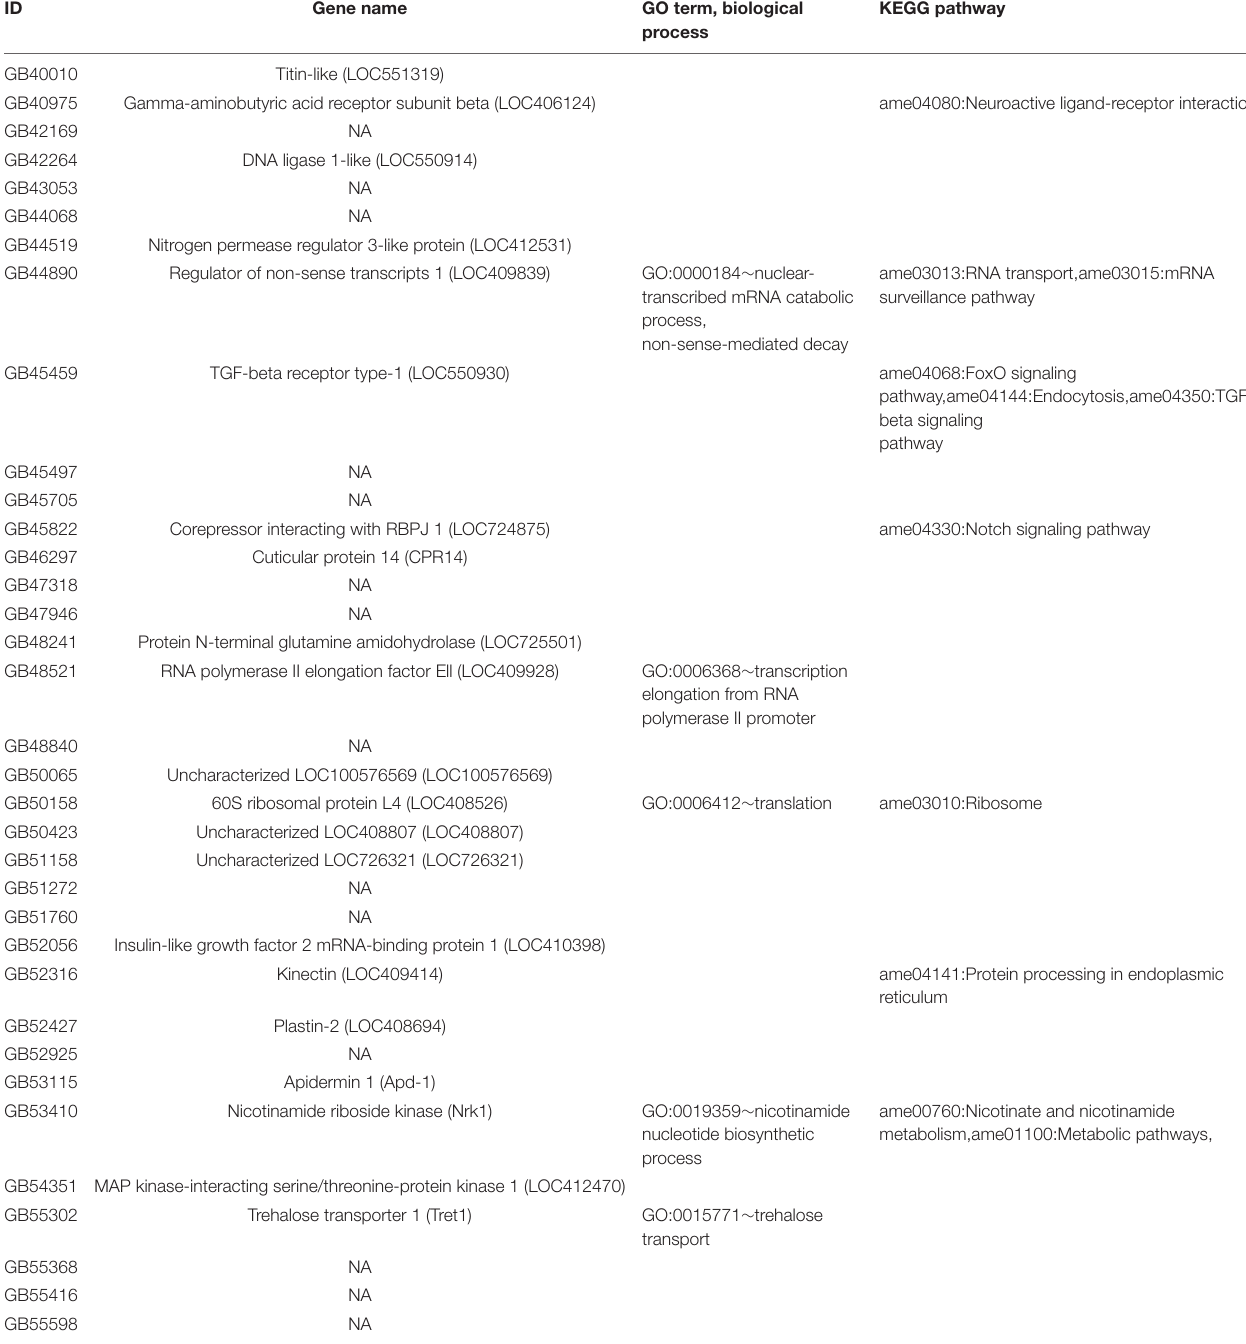
TABLE 2 | Functions of the 35 shared DEGS identified in four developmental